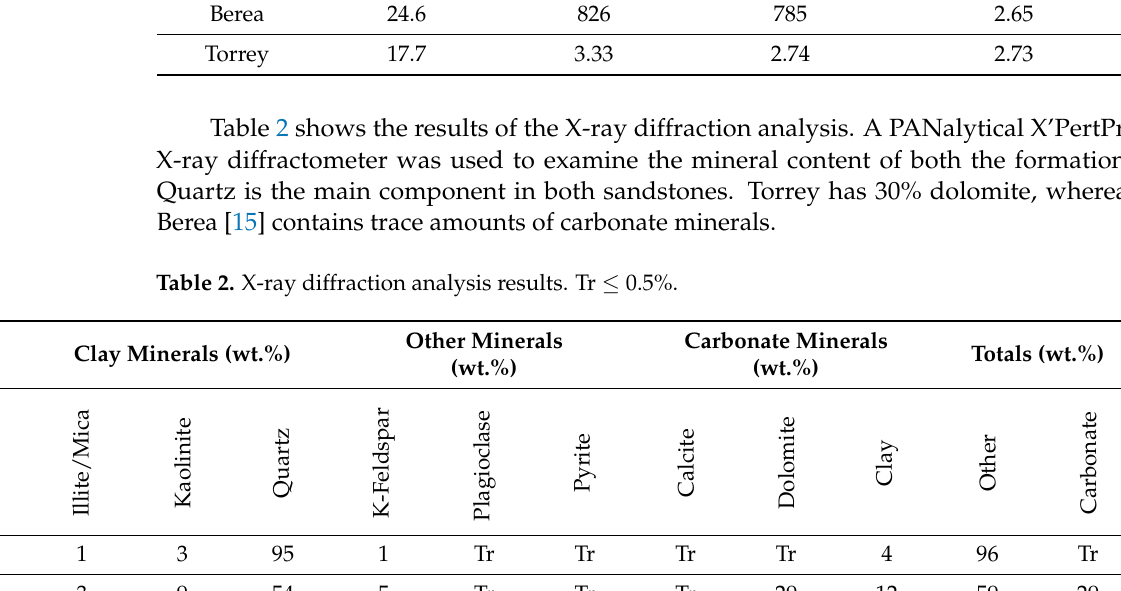
Table 1. Mean porosity, permeability, and grain density of formations. Formation Porosity (%)